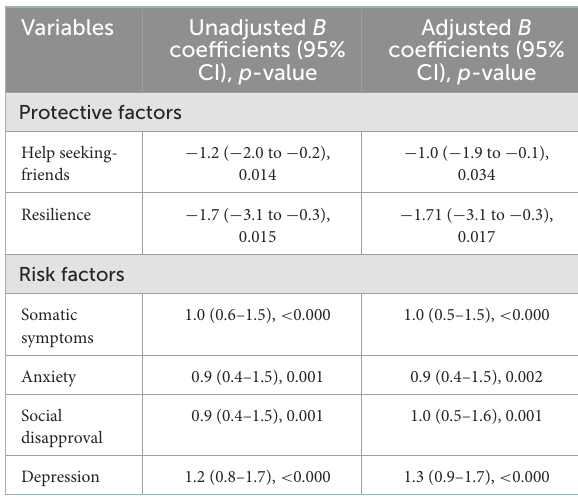
TABLE 3 Risk and protective factors for